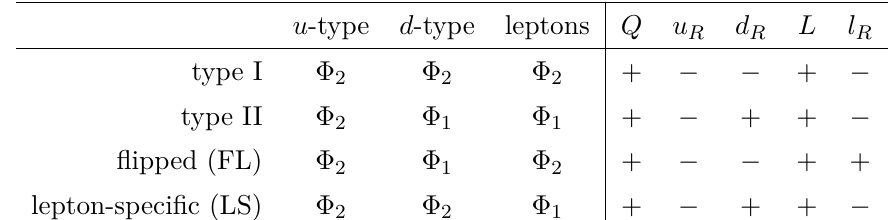
assignment 2 , the lepton R